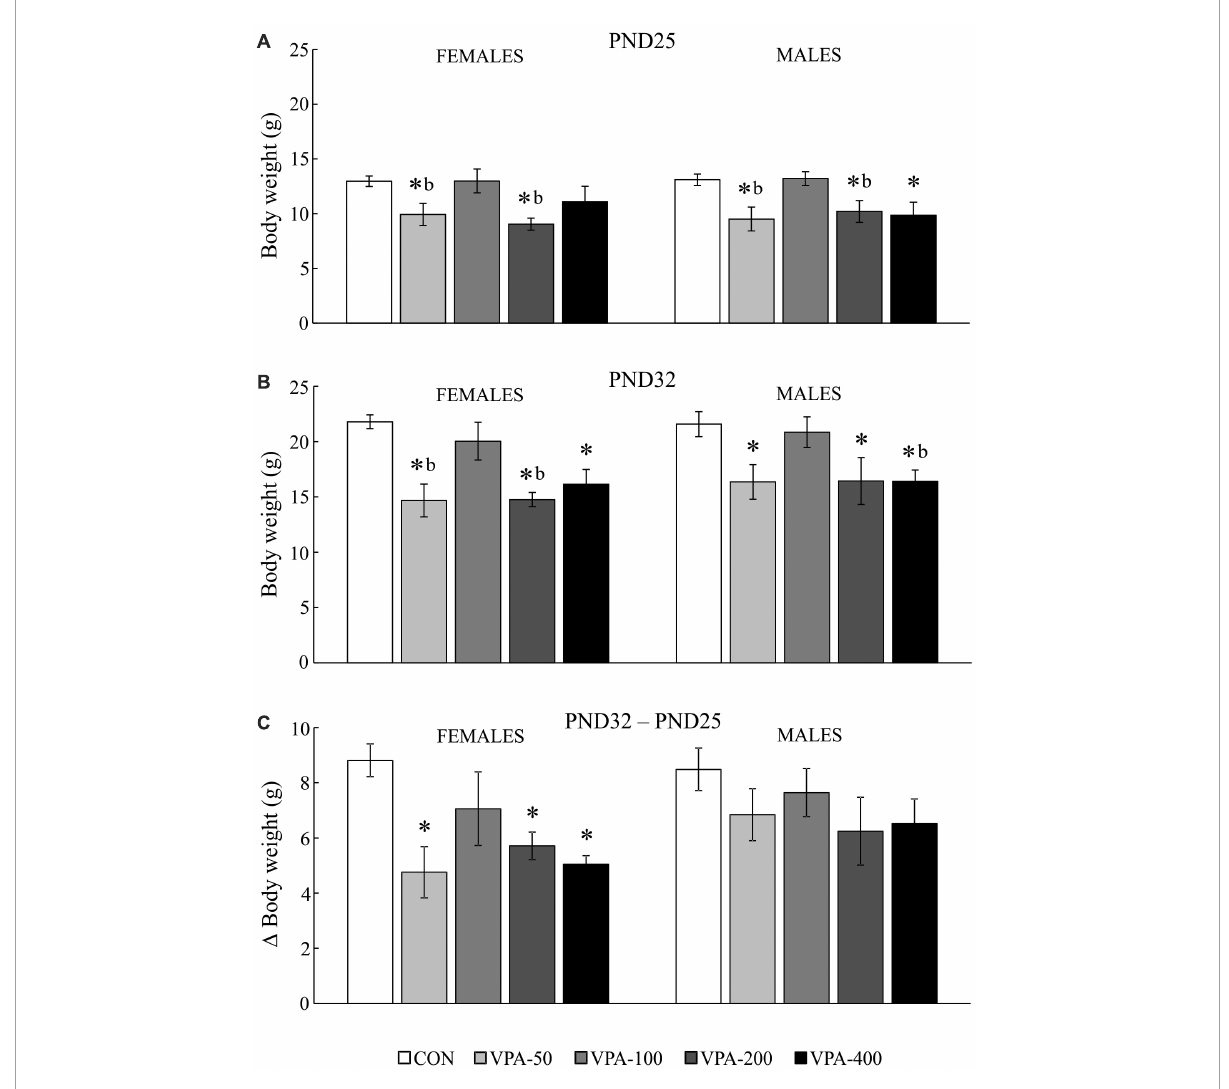
FIGURE1 Average body weight (BW) of adolescent female and male mice prenatally exposed to VPA at doses of 50 mg/kg (VPA-50), 100 mg/kg (VPA-100), 200 mg/kg (VPA-200), and 400 mg/kg (VPA-400). The animals were weighed on PND25 (A) and PND32 (B) ; based on the obtained parameters weight gain was calculated (C) as the BW on PND32 (g) – BW on PND25 (g). Each bar represents the mean ± SEM ( n = 7 mice/group/sex). * p < 0.05 compared to the control (CON) group treated with saline; b p < 0.05 compared to the VPA-100 group ( U -test).